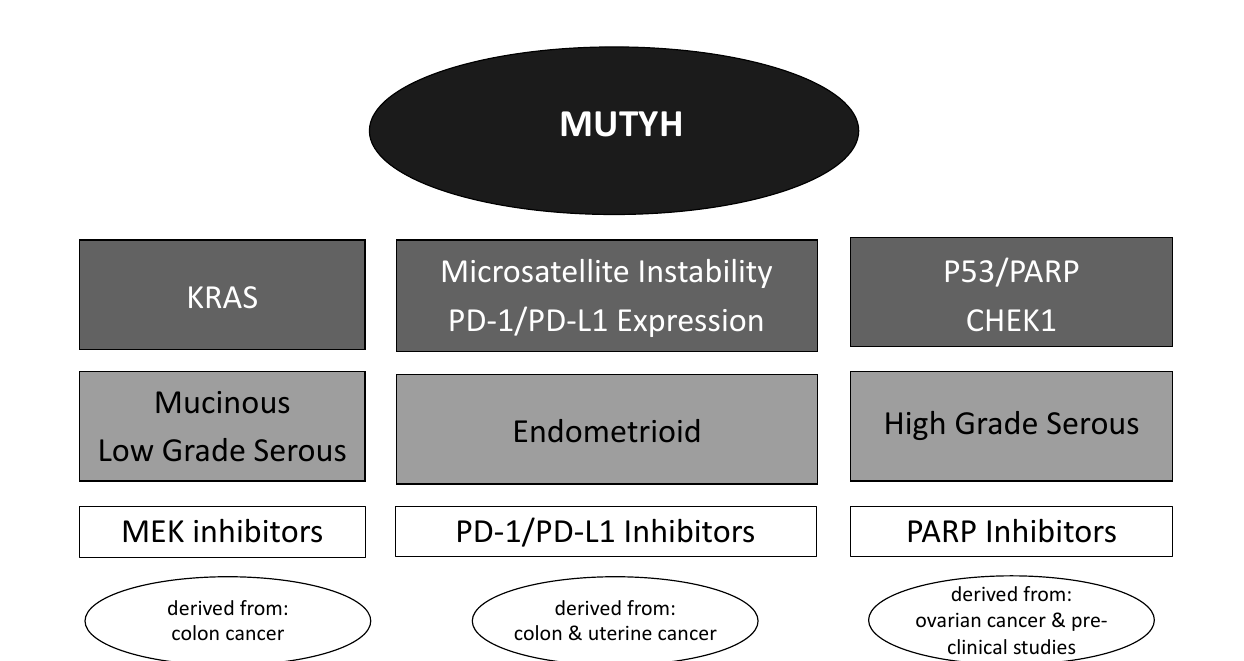
Figure 3. Molecular aberrations, their associated histologic subtypes, potential targeted therapeutics, and origin of treat- ment considerations.